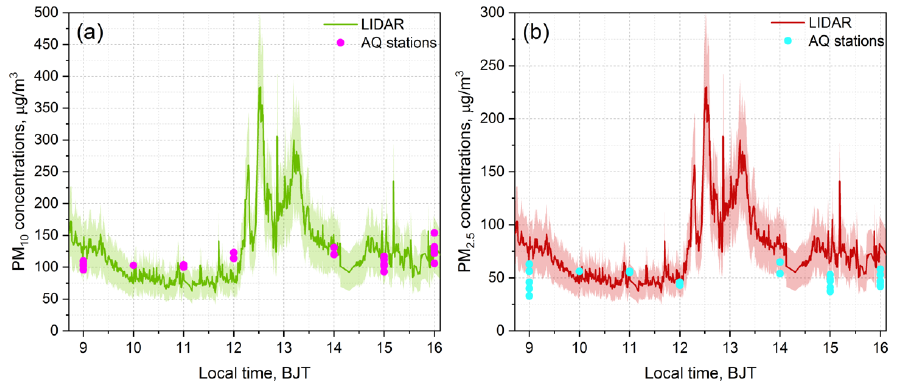
Figure 11. Spatio-temporal variability of ( a ) PM 10 (green) and ( b ) PM 2.5 (red) at surface level, derived from LIDAR profiles, and the mean hourly PM 10 (magenta) and PM 2.5 (cyan), measured at the closest air quality (AQ) stations to the route (BJT = Beijing time). The shaded area on each curve represents the uncertainty of 32% on the LIDAR-derived mass concentrations.